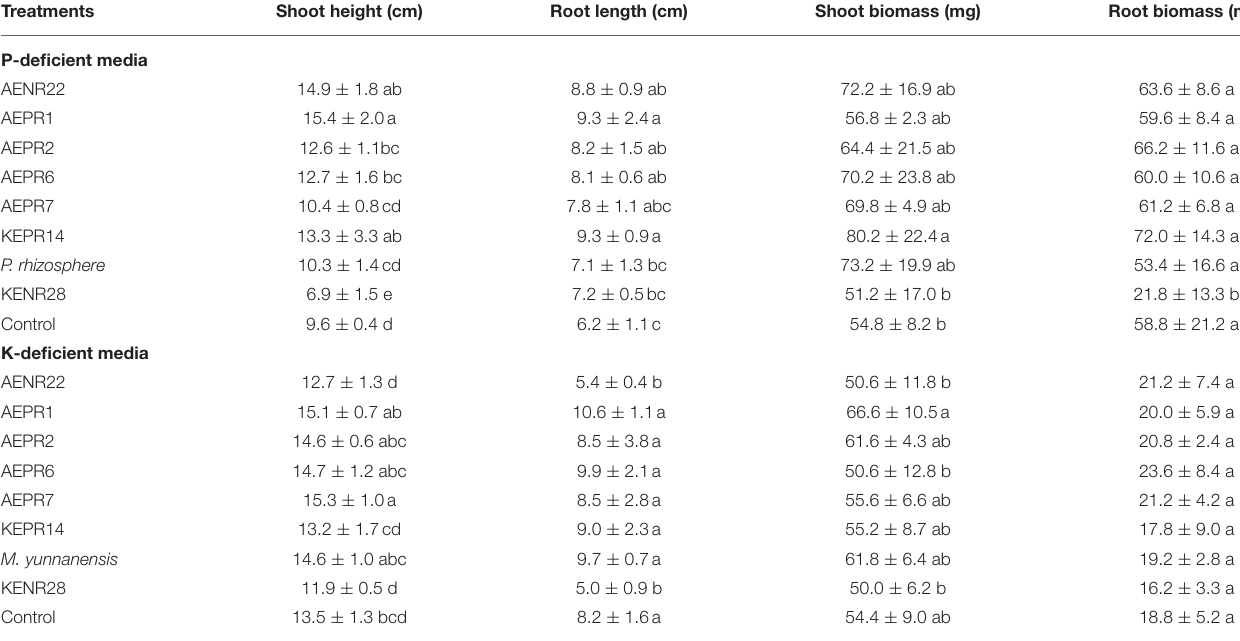
TABLE 2 | Effects of selected isolates on rice plants under P-deficient and K-deficient media.